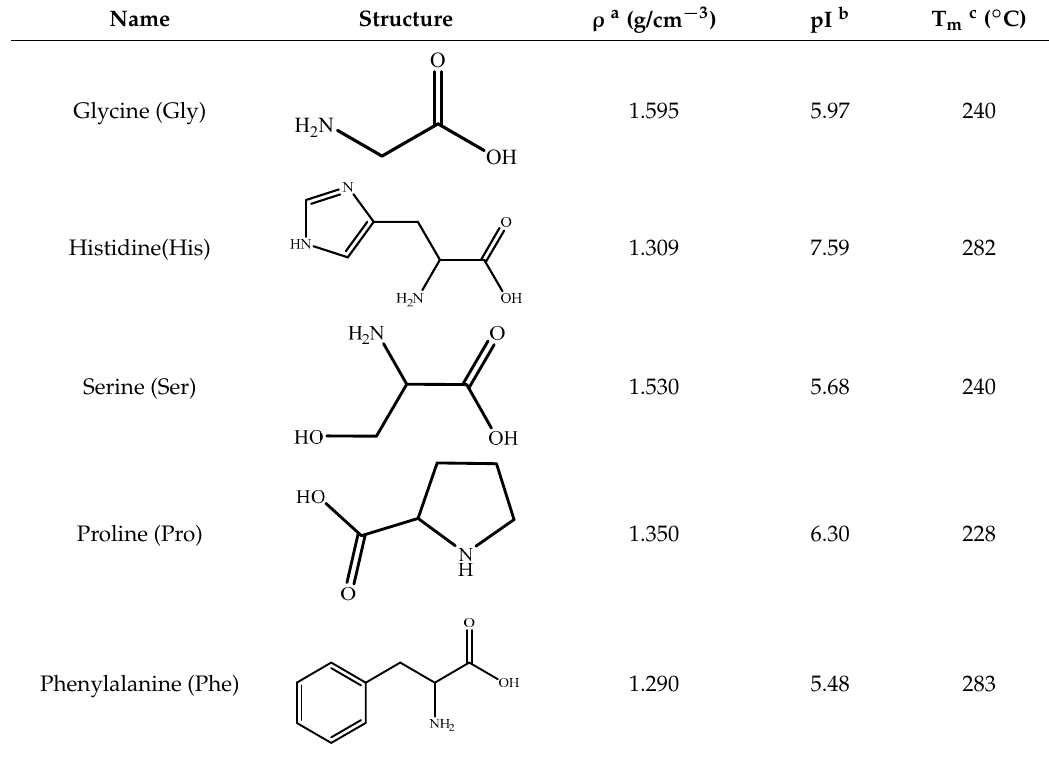
Table 1. Physicochemical Properties of the Amino Acids used in this Study.